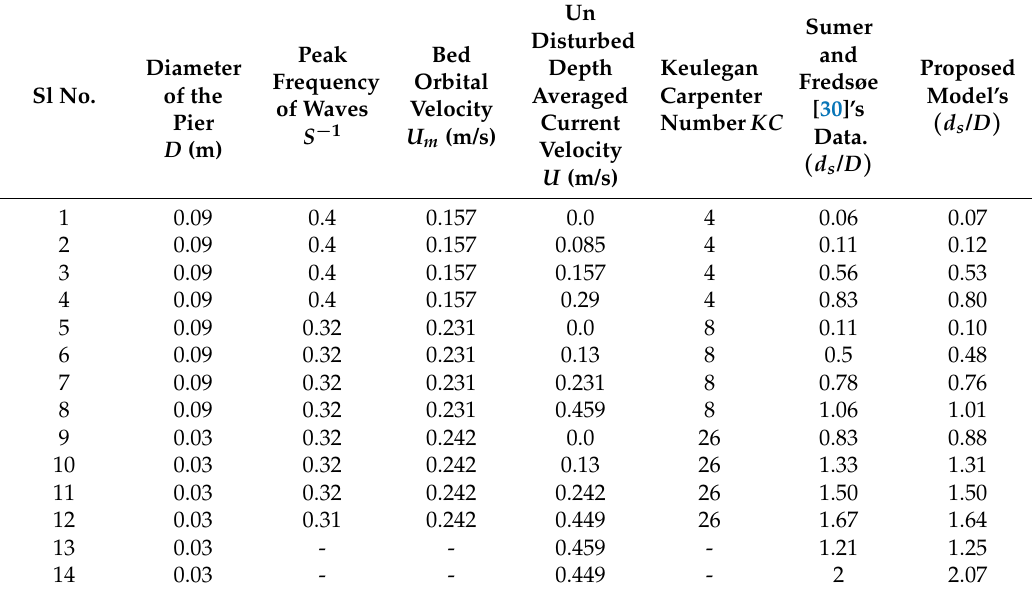
Table 1. Comparison of the calculated non-dimensional scour depth ( d s / D ) with the corresponding values obtained from the experimental work of Sumer and Fredsøe [30].